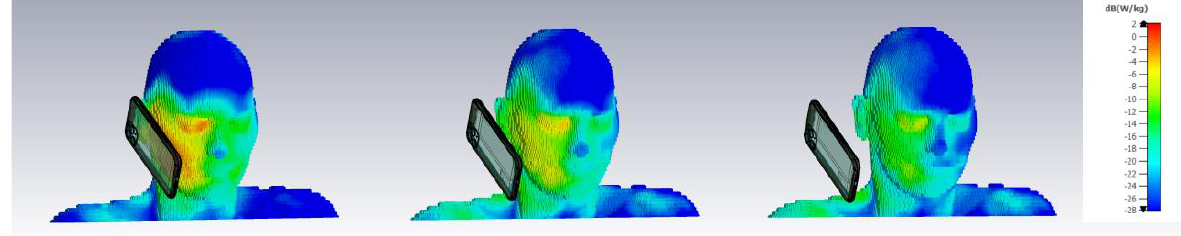
Figure 4. Placing a cell phone antenna at 0, 2, and 6 cm from the head reduces the Percentage of Power absorbed by the head (PPHead, %). 0 dB is 1 W/kg Specific Absorption Rate. Figures 4 – 7 are simulations from Bio extension 4.3 of CST Studio Suite.